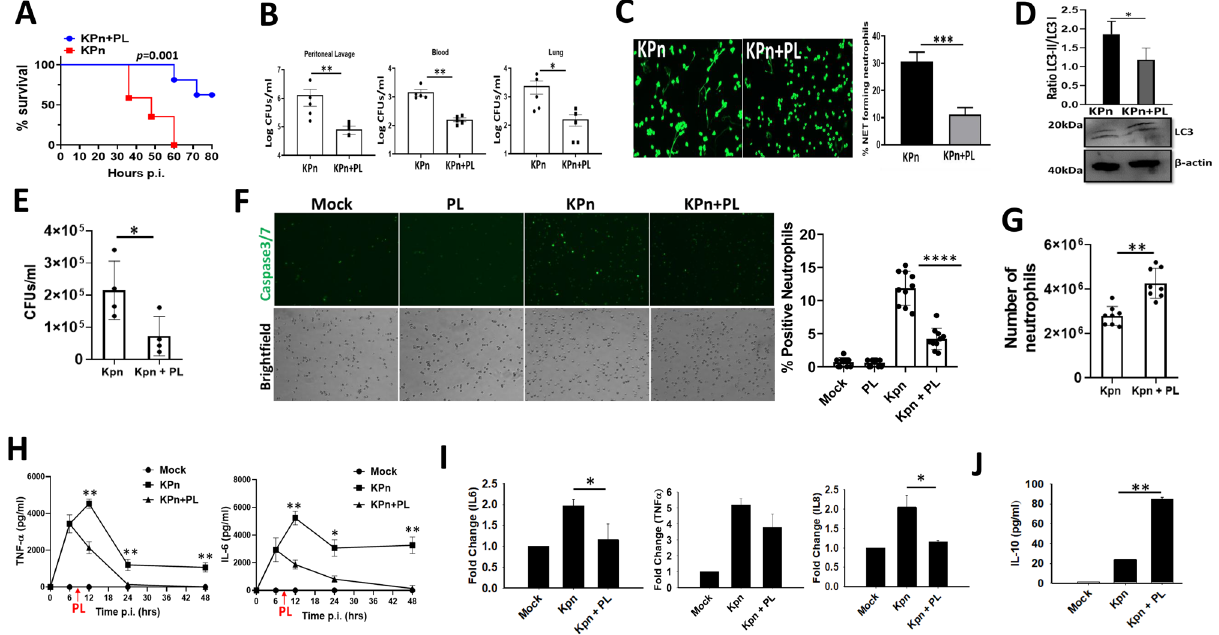
Figure 2. PL treatment improves murine septic peritonitis by regulating inflammatory response. ( A ) Survival of C57Bl/6 mice infected intraperitoneally with 5.0 × 10 3 CFUs of KPn with or without PL treatment (20 mg/ Kg injected intraperitoneally 8 h after infection). ** p = 0.0015 by Kaplan–Meier log-rank test. n = 15 KPn and 17 KPn + PL in 3 independent experiments. ( B ) Bacterial load in peritoneal lavage, blood and lungs of mice at 24 h p.i. with KPn with or without PL treatment (20 mg/kg, 8 h p.i). (*p < 0.05; **p < 0.01). The experiment was repeated twice with 5 mice each time in each group. ( C ) Representative fluorescence images of the neutrophils isolated 24 h p.i. from peritoneal lavage fluid of mice infected with KPn with or without PL treatment (20 mg/ kg, 8 h p.i.), and stained with Sytox Green to label NETs (green). Magnification 200X. The bar graph shows average ± SE of NETs from 4 independent experiments. (***p < 0.001). ( D ) Western blot analysis of autophagy in peritoneal neutrophils purified from mice infected with KPn with or without PL treatment. Uncropped blots are provided in the supplementary material. Bar graph depicts densitometry analysis of protein band intensities expressed as ratio of LC3-II to LC3-I protein. ( E ) Bacterial CFUs in neutrophils purified from peritoneal lavage of KPn infected mice isolated at 24 h p.i. with or without PL treatment. Magnetic column purified peritoneal neutrophils were washed twice with complete RPMI and lysed in sterile solution of 0.1% TritonX-100 before plating the serial dilutions on LB agar plates. The data shown is representative of three independent experiments with 4–5 mice in each group (*p < 0.05). ( F ) Representative images of cytocentrifuged neutrophils purified using magnetic columns as described in methods, from peritoneal lavage cells isolated at 24 h p.i. from mice infected with KPn with or without PL treatment. Neutrophils were processed for Caspse3/7 activation (green) by using CellEvent™ Caspase-3/7 Green Detection Reagent. Corresponding phase contrast images are shown to indicate the cell density in each sample. The bar graph depicts percentage of apoptotic neutrophils exhibiting active Caspase3/7 staining. Data from 5 mice in each group in 2 independent experiments is shown (****p < 0.0001). ( G ) Absolute numbers of neutrophils purified by positive selection from peritoneal lavage of PL treated and untreated KPn infected mice at 24 h p.i. is shown. Each dot represents neutrophil counts from one mouse (**p < 0.01). ( H ) Levels of Inflammatory cytokines were measured by ELISA in peritoneal lavage fluid at indicated times post-infection from mice infected intraperitoneally with KPn with or without PL treatment. Data is shown as average ± SE from 2 independent experiments with 3–4 mice in each group (**p < 0.01; ***p < 0.001). ( I ) Real Time PCR analysis of mRNA expression of inflammatory cytokines in peritoneal neutrophils purified as in ( D ). Data is shown as fold change in mRNA expression of IL-6, TNF-α and IL-1β over their respective baseline control level in neutrophils isolated from mock control animals (*p < 0.05). ( J ) Protein levels of IL-10 were measured in the culture supernatant of purified neutrophils incubated in complete RPMI for 2 h, using Legendplex MU Cytokine Release Syndrome Panel (13 Plex), following manufacturer’s instructions (BioLegend). Neutrophils were purified from peritoneal lavage isolated at 24 h p.i. from mock control (PBS alone) and KPN infected (with and without PL